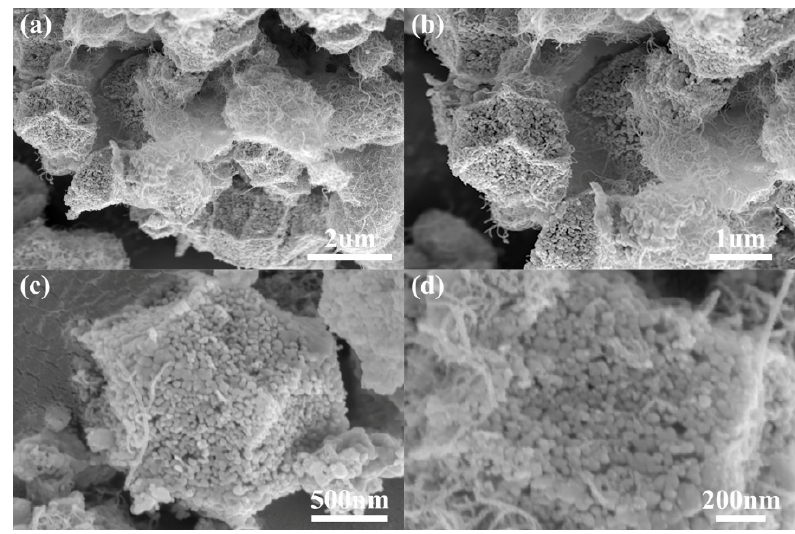
Figure 3. FSEM images of C-MOF/MWCNTs at various magnifications. ( a ) under the field of view of 2 um; ( b ): under the field of view of 1 um; ( c ): under the field of view of 500 nm; ( d ): under the field of view of 200 nm.